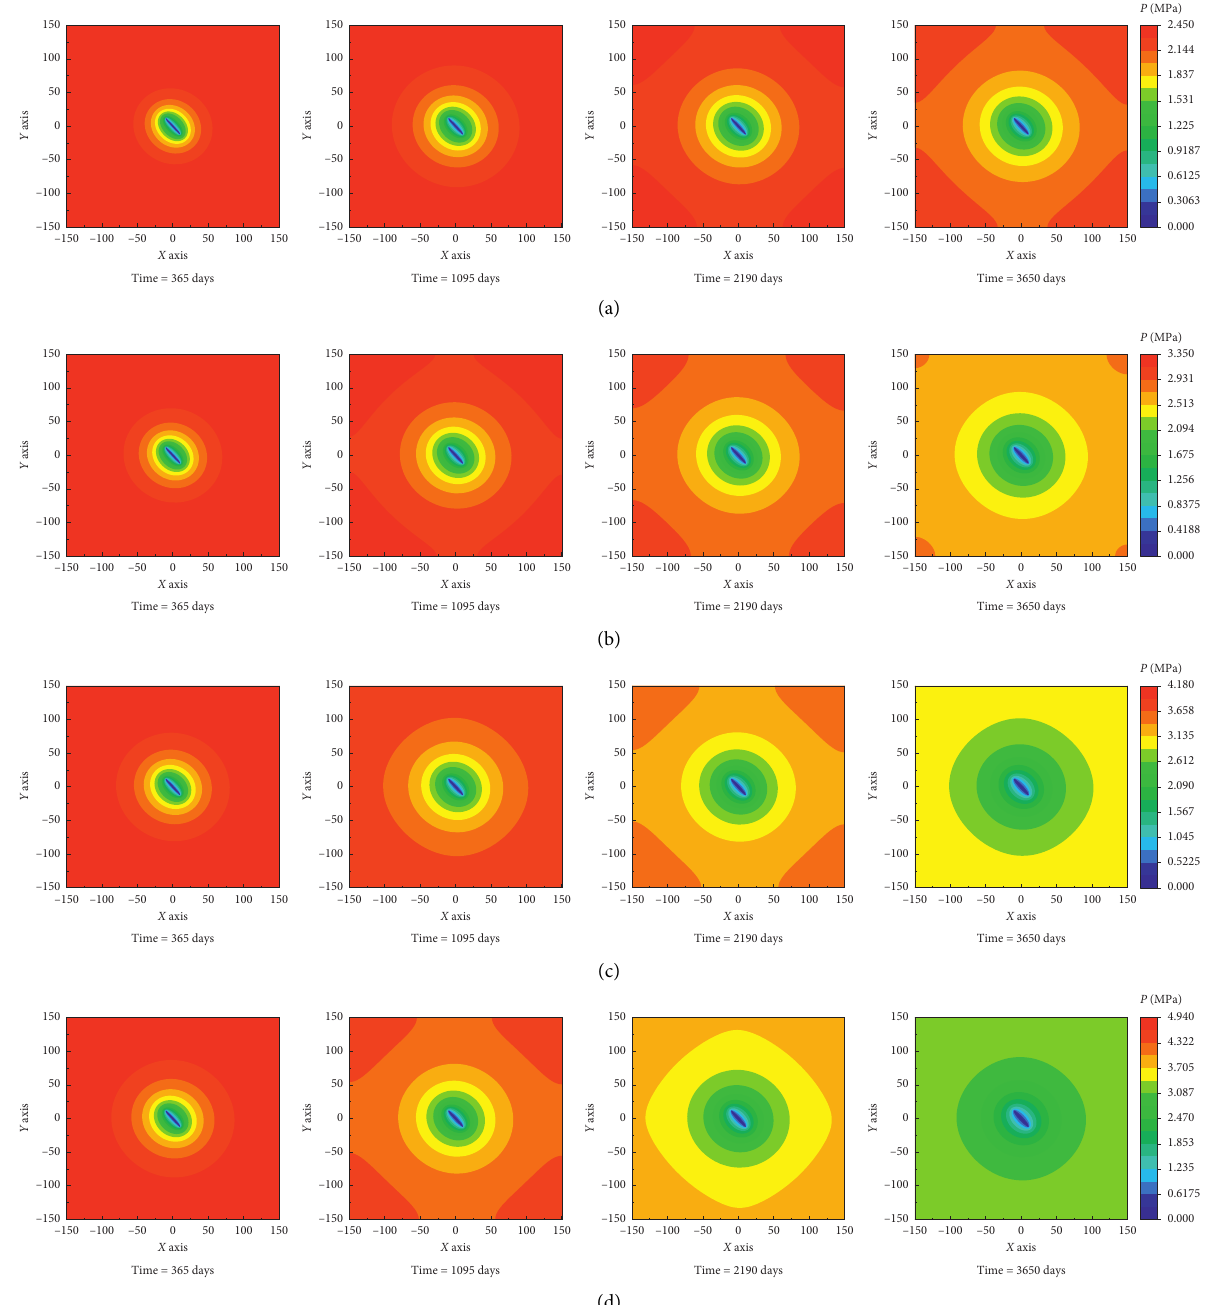
Figure 8: Variation of coalbed methane pressure with different initial coalbed pressure. (a) P (c) P 0 � 4.53 MPa. (d) P 0 �